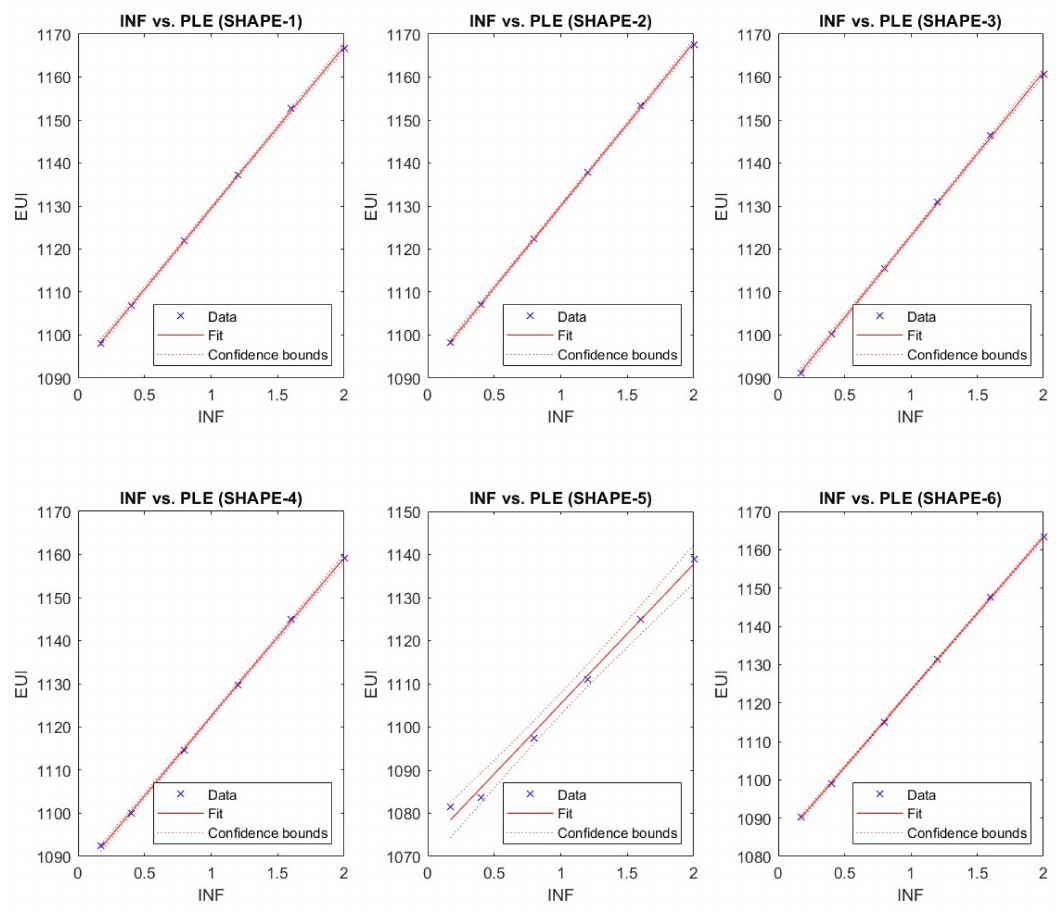
Figure 17. Fitted lines of infiltration